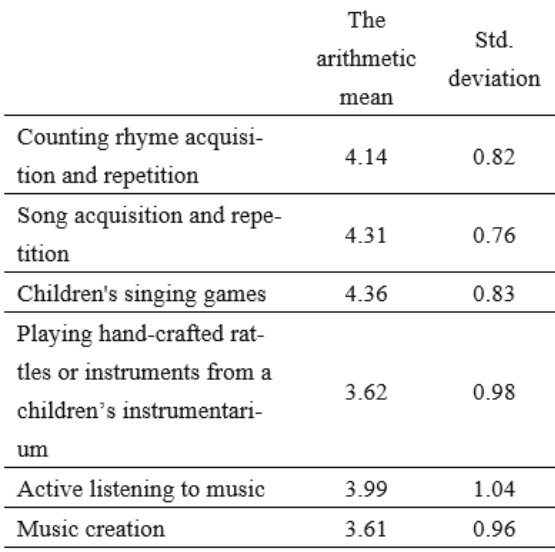
Table 3. Frequency of implementing